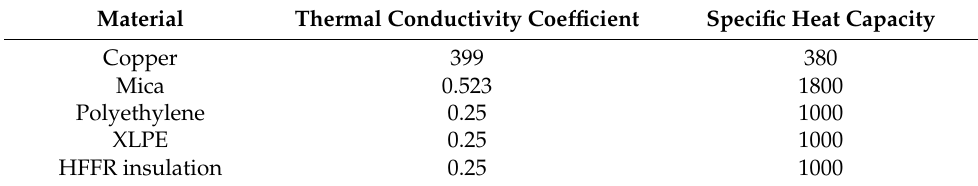
Figure 5. Temperature curve model simulation. Table 1. Thermal coefficients of the components of studied cable.